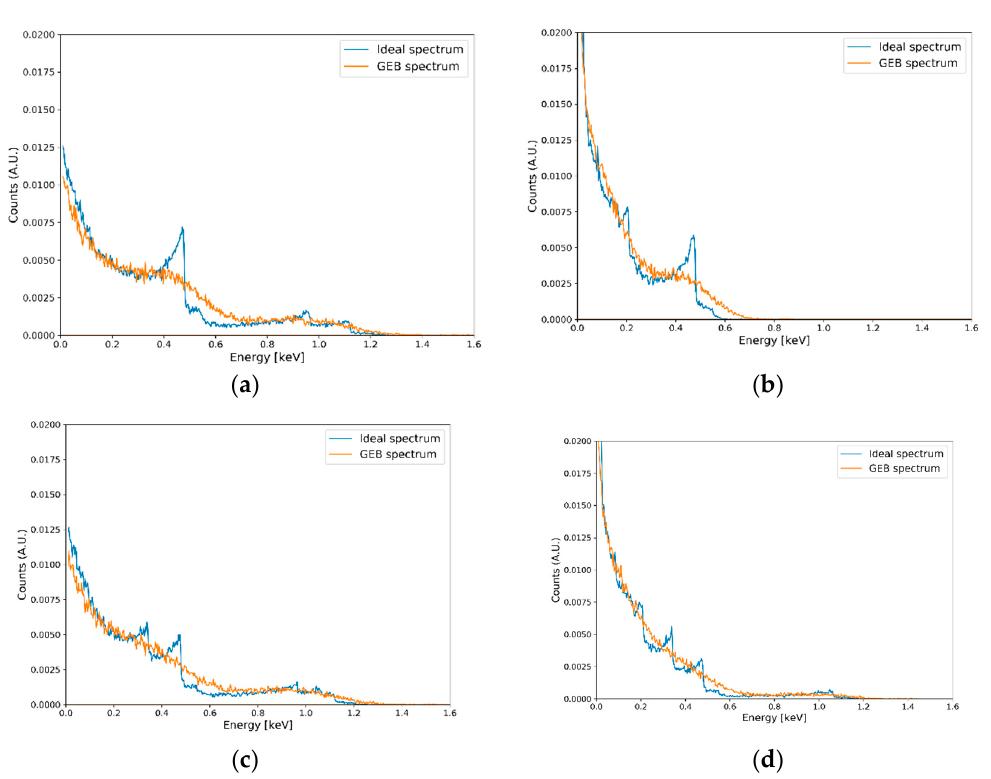
Figure 4. Examples of generated datasets for di ff erent synthesis ratios: ( a ) 70% 22 Na and 30% 60 Co; ( b ) 60% 137 Cs, and 40% 133 Ba; ( c ) 30% 22 Na, 30% 60 Co, and 40% 137 Cs; and ( d ) 40% 22 Na, 30% 133 Ba, and 30% 137 Cs.